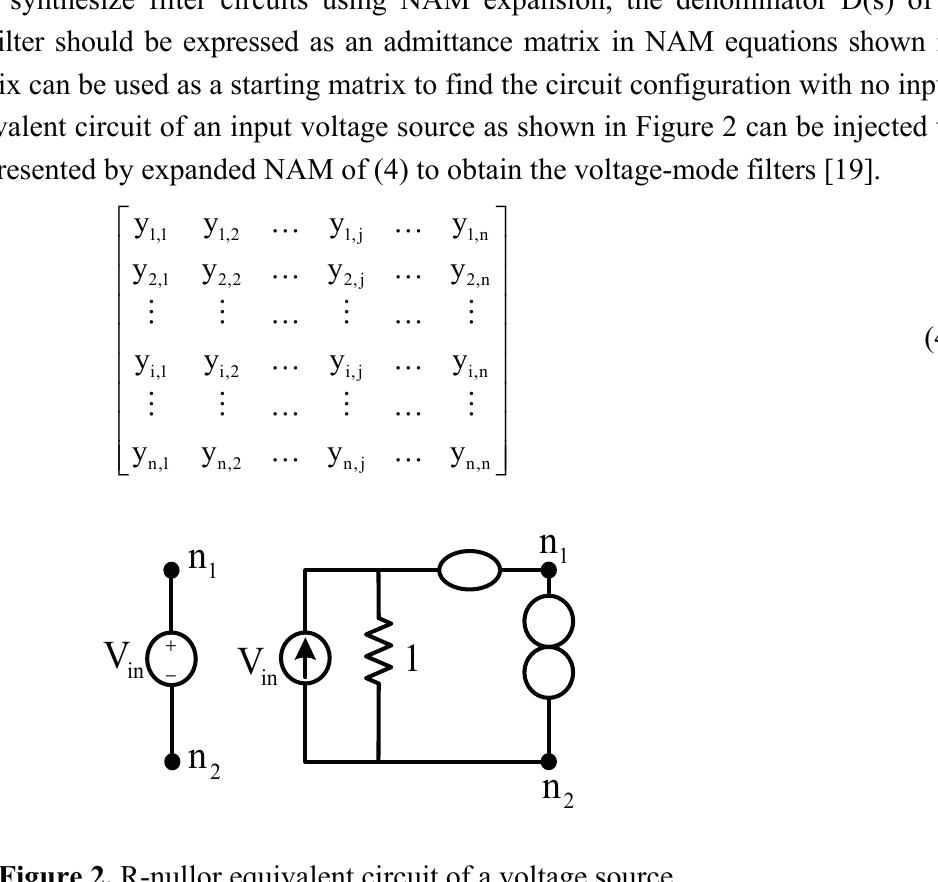
Figure 2. R-nullor equivalent circuit of a voltage